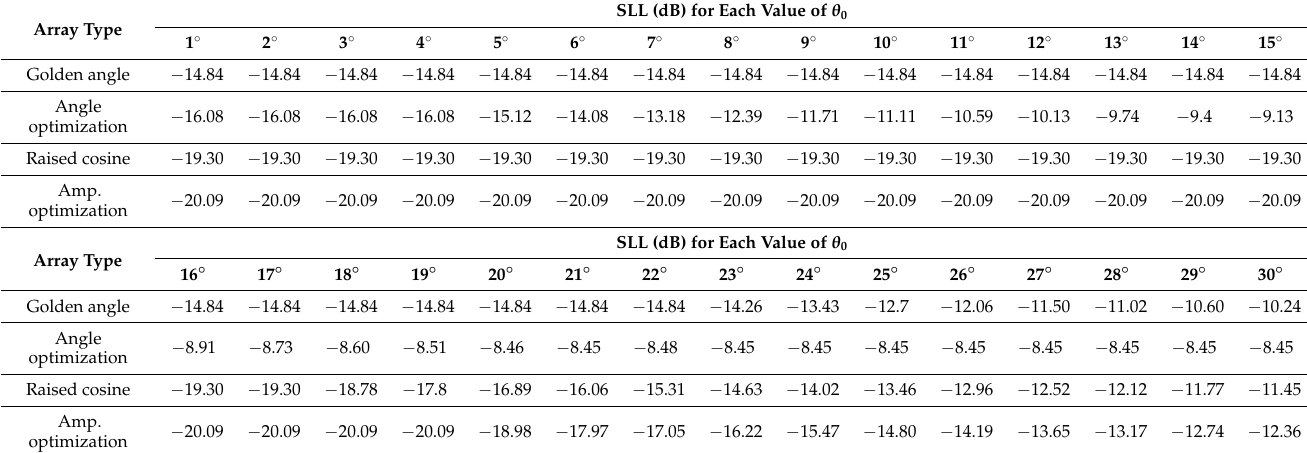
Table 2. A comparative analysis of the proposed techniques, considering